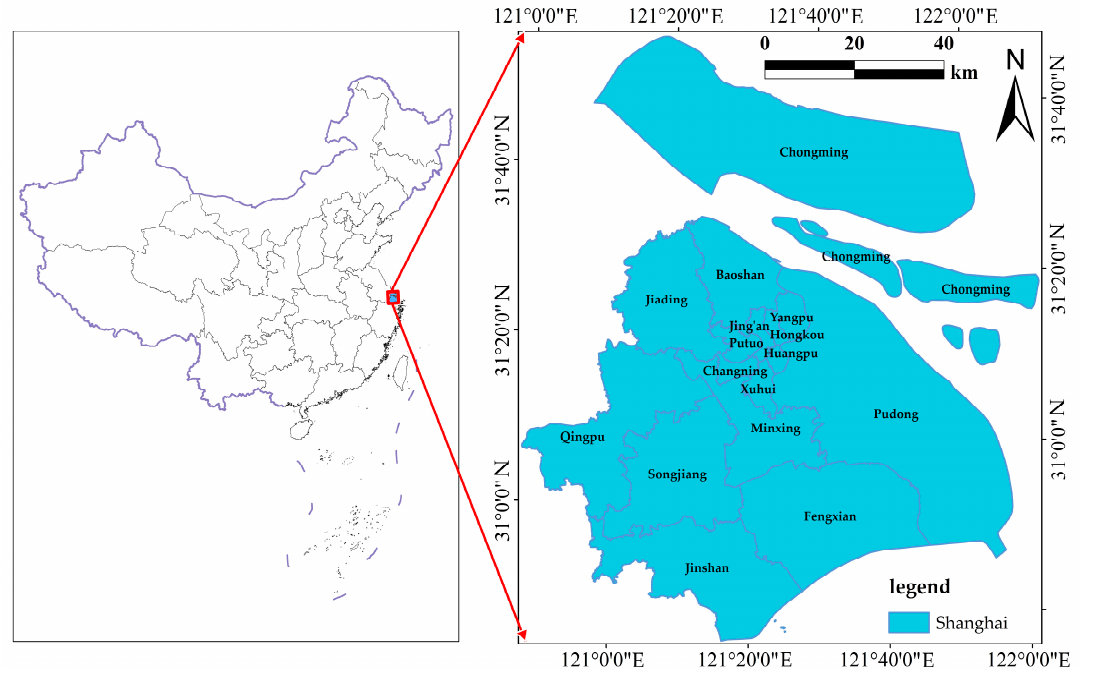
Figure 1. Study area.